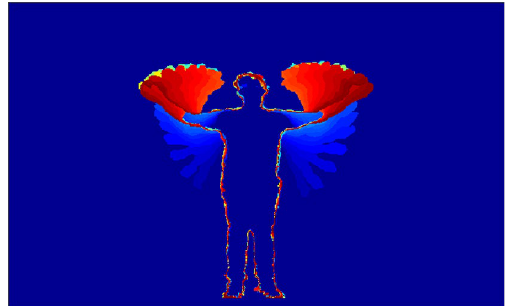
Fig. 3 Motion history image of two hand wave action